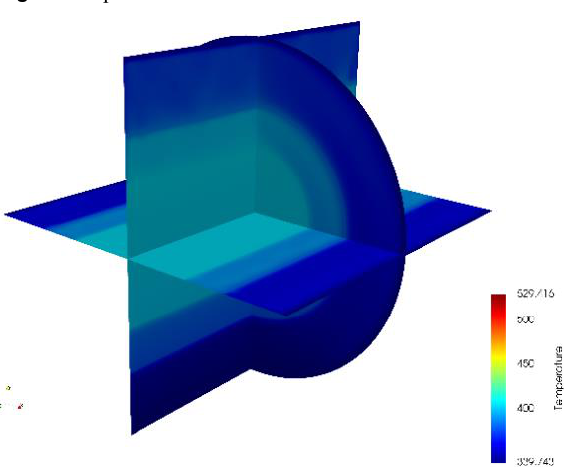
Fig. 7. Temperature field after 30 minutes .